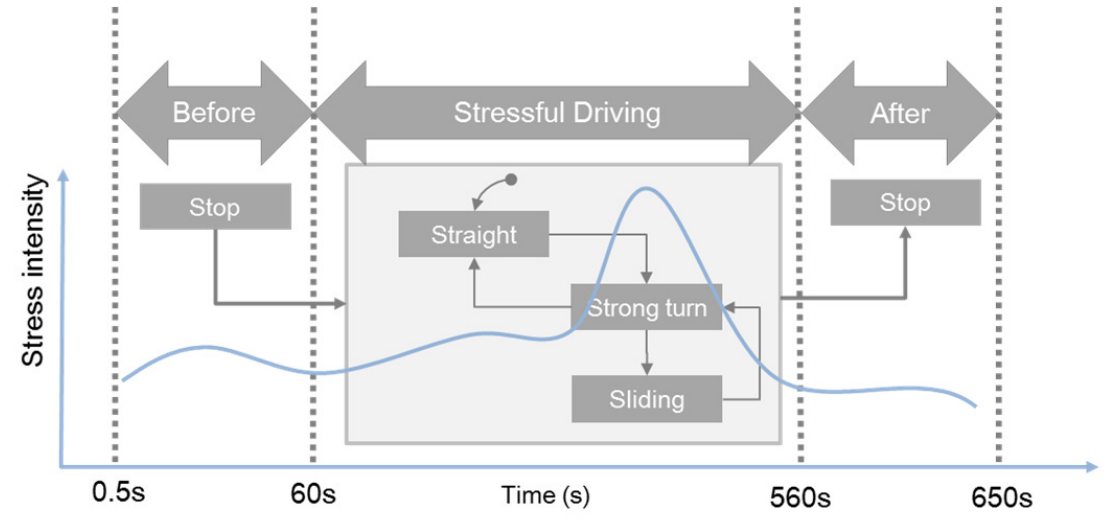
Figure 2. Experimental stages. Data were collected over the course of 11 minutes divided into three stages. During the main stage of the experiment (stressful driving; 500 seconds), the subjects were instructed to drive a vehicle on a difficult course with sharp turns. During the initial (before-driving) and final (after-driving) stages of the experiment, the subjects were instructed to